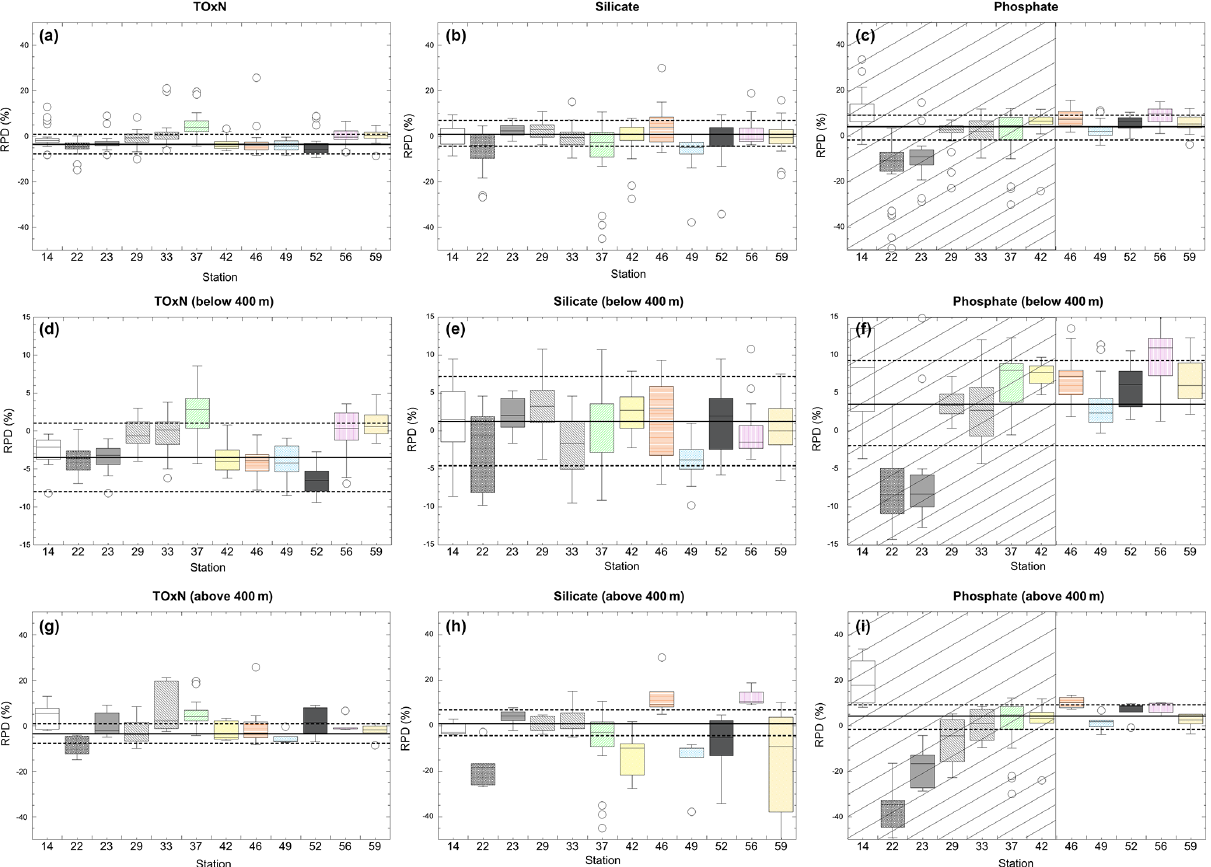
Figure 5. Box plots of relative percent differences (RPD) between MI and Dal measurements on water samples that were analysed on both systems. RPDs are calculated as (MI conc − Dal conc) / average conc × 100%. The median RPD(%) for a station defines the centre line of each box, and the entire box, representing the interquartile distance (IQD), is closed by the upper (UQ) and lower quartiles (LQ). Individual data points identify outliers, defined as LQ − 1 . 5 × IQD and UQ + 1 . 5 × IQD. The top row (a–c) represent results from all depths, whereas the middle (d–f) and lower (g–i) rows represent results for samples from > 400m and < 400m, respectively. ToxN, silicate and phosphate data are presented in the left (a, d, g) , middle (b, e, h) and right (c, f, i) rows. Note the use of different y -axis scales for the different depth ranges. For phosphate, the shaded area denotes the period prior to Station 46, after which the Dal standard curve was altered. The horizontal lines represent the cruise-wide means (solid line) and uncertainties (dashed lines) between MI and Dal measurements of the KANSO CD CRMs for each nutrient. The uncertainty bounds represent ± 1 standard deviation, which was calculated from the respective standard deviations of the differences from certified values of the MI and Dal analyses, summed in quadrature. TOxN and silicate were calculated using results from all CD CRMs measured during the cruise. The lines for the average and standard deviation for phosphate relate only to the later (non-shaded) portion of the